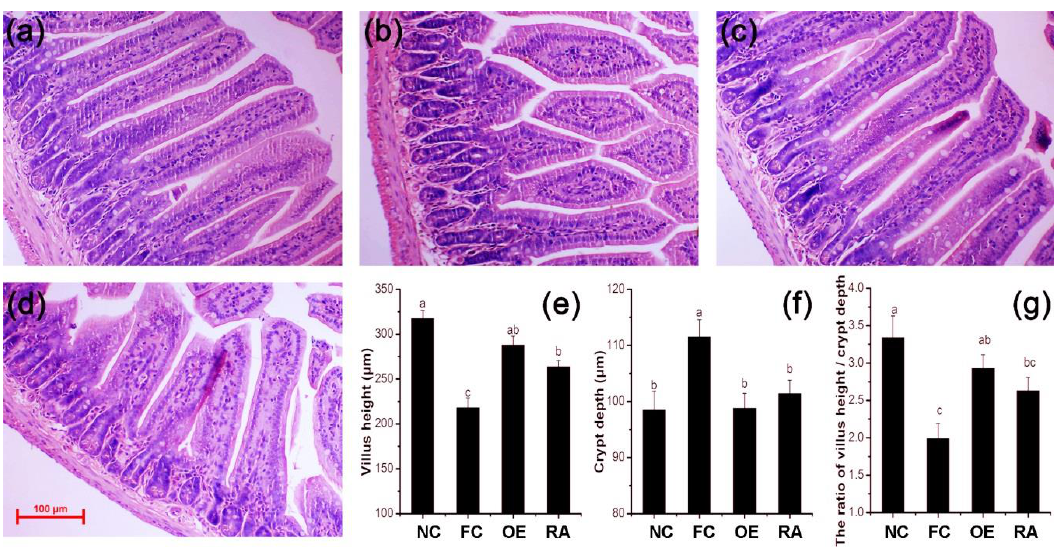
Figure 3. OE and RA alter jejunum villus and crypt structure in mice. ( a – d ) Representative hematoxylin and eosin (H&E) histology of the jejunum in mice after different treatments. ( a ) NC group; ( b ) FC group; ( c ) OE group; ( d ) RA group. ( e , f , g ): At least ten typical villi were measured for each mouse. The bar represents the SEM, with different letters being statistically significantly different ( P < 0.05). A higher magnification figure is shown in S4